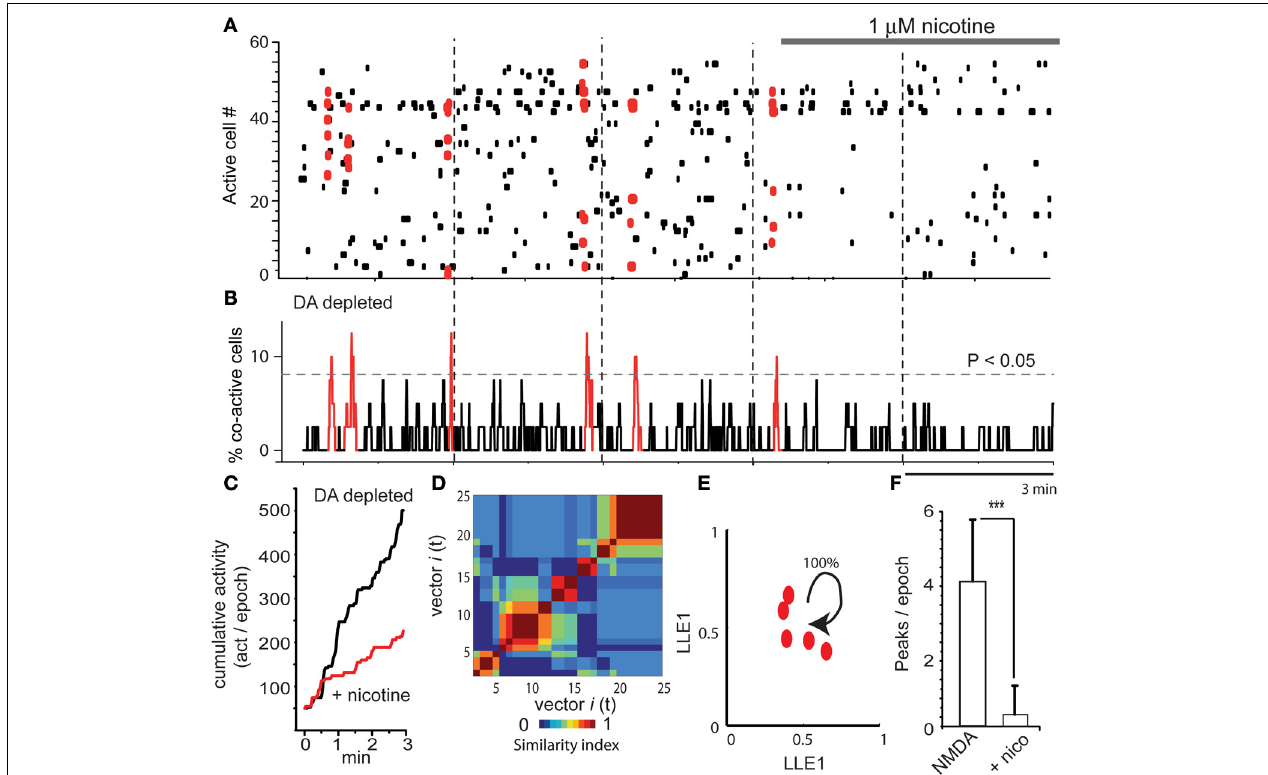
FIGURE 5 | Nicotine inhibits Parkinsonian activity in the dopamine depleted striatal microcircuit. (A) Raster plots showing five epochs of activity in a DA-depleted striatal circuit. There is spontaneous neuronal activity in the absence of NMDA (first three epochs shows activity in a 6-OHDA rodent model of hemi-Parkinsonism, see Materials and Methods). However, significant synchronization is composed of the same neuron pool. Last two epochs show that nicotine reduces this activity. (B) Note that activity during DA deprivation exhibits significant peaks of synchronization. However, all are depicted with the same color since similarity indexes indicate that these vectors are built with a similar set of neurons presenting